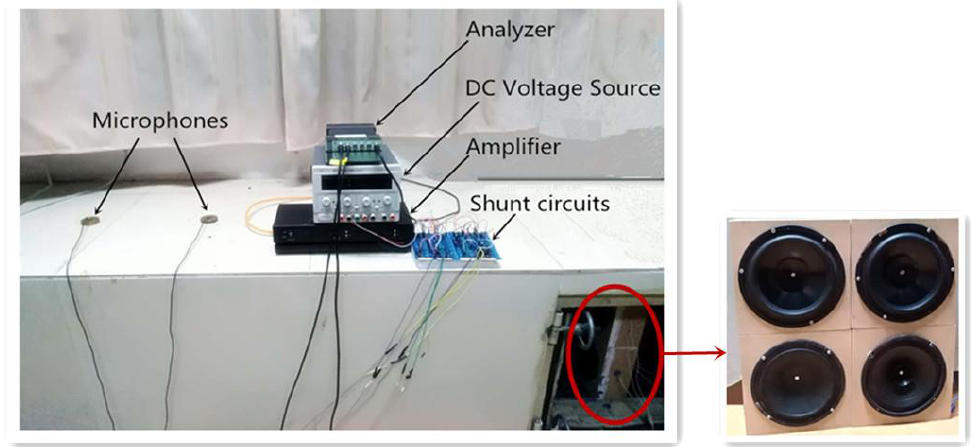
Figure 5. Measurement setup of the shunted loudspeaker array.